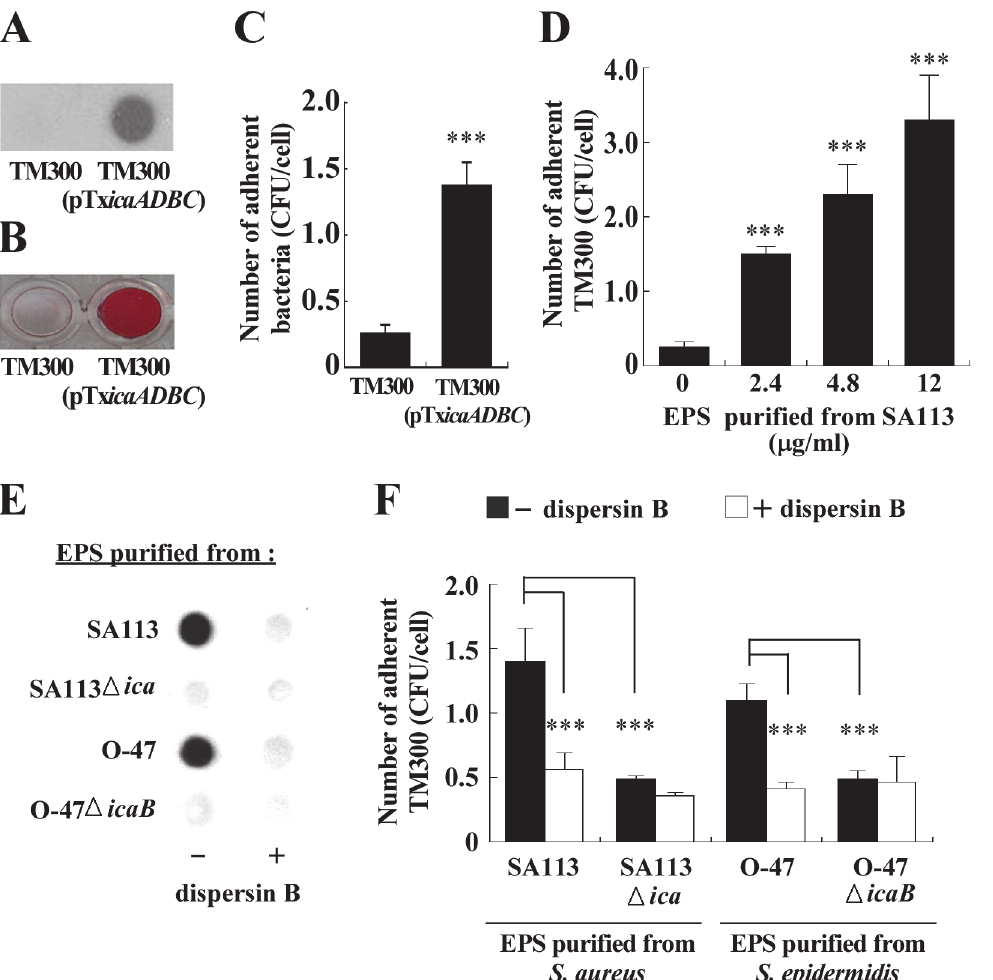
Fig 4. Effects of PIA/PNAG on the adherence of S . carnosus TM300 to epithelial cells. PIA/PNAG production (A), biofilm formation (B) and adherence of S . carnosus TM300 and S . carnosus TM300(pTX icaADBC ) to RPMI 2650 cells (C) were determined. (D) EPS that was purified from S . aureus SA113 at various concentrations was mixed with S . carnosus TM300 and incubated with RPMI 2650 cells. The average number of S . carnosus TM300 that adhered to each RPMI2650 cell was determined. EPS (2.4 μ g/ml) from S . aureus SA113, SA113 Δ ica , S . epidermidis O-47 and S . epidermidis O-47 Δ icaB was treated or untreated with 0.5 mg/ml dispersin B. The amounts of PIA/PNAG were determined by WGA-biotin (E). The average number of S . carnosus TM300 adhered to each RPMI2650 cell was determined by CFU enumeration (F). Significant differences are denoted with *** p -value <